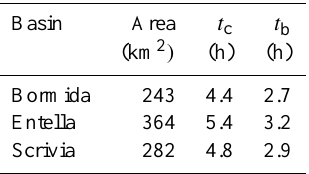
Table 3. Characteristics of the considered catchments with an area greater than 150km 2 . t c is the basin concentration time and t b is the basin lag